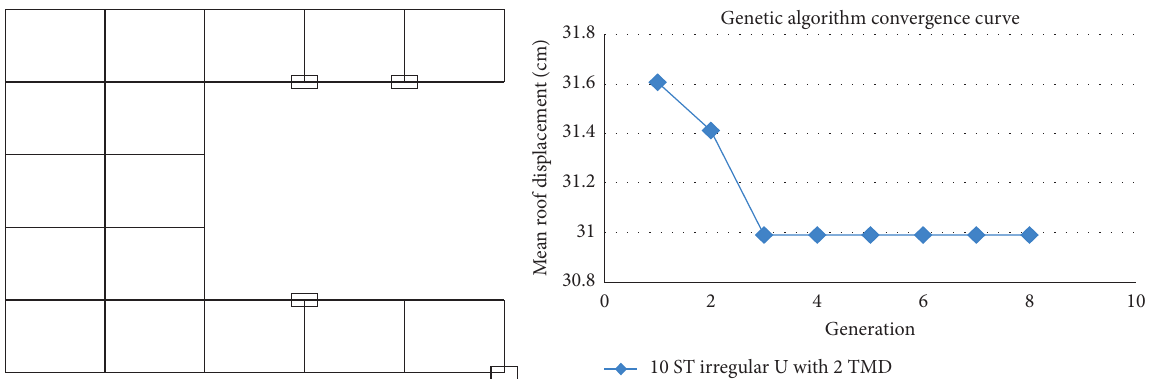
Figure 23: Convergence diagram of the ten-story U-shaped model with 2 dampers in genetic algorithm (right) and damper optimal positions (left).